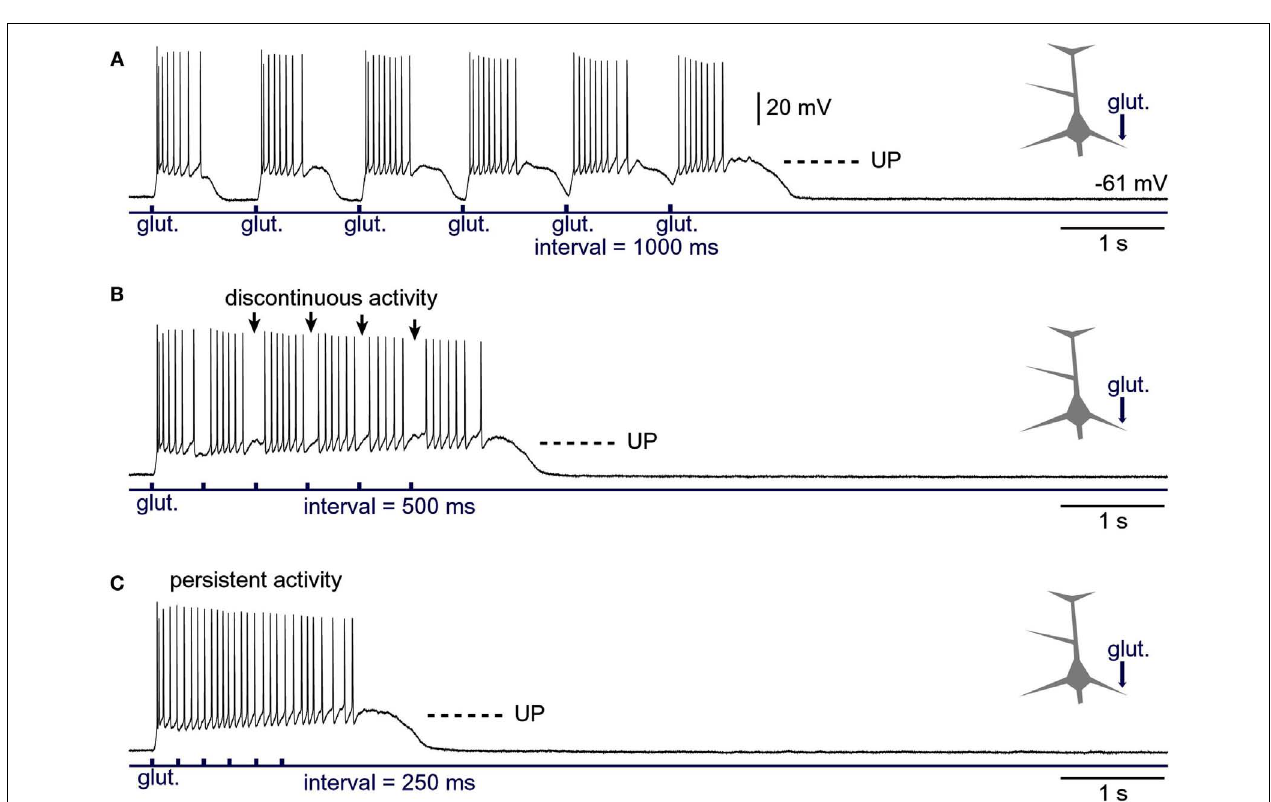
subsequent sweeps (B,C) , the inter-pulse interval was gradually decreased, as indicated below the trace. Arrows in (B) mark pauses in AP